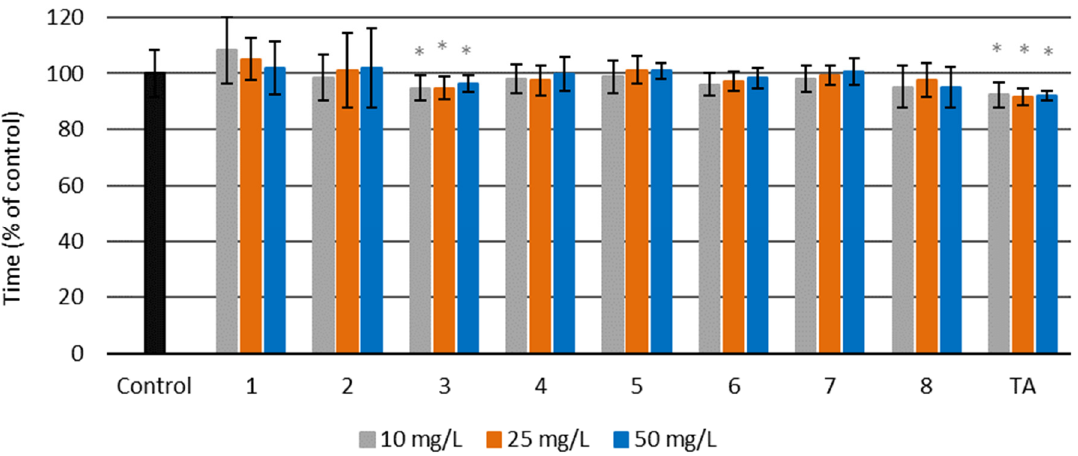
Figure 9. Activated partial thromboplastin time (aPTT) for amides 1–8 and tranexamic acid (TA) at three different concentrations—10, 25, and 50 mg/L—and for the control sample of human blood plasma (untreated with the examined amides) ( * p < 0.05).